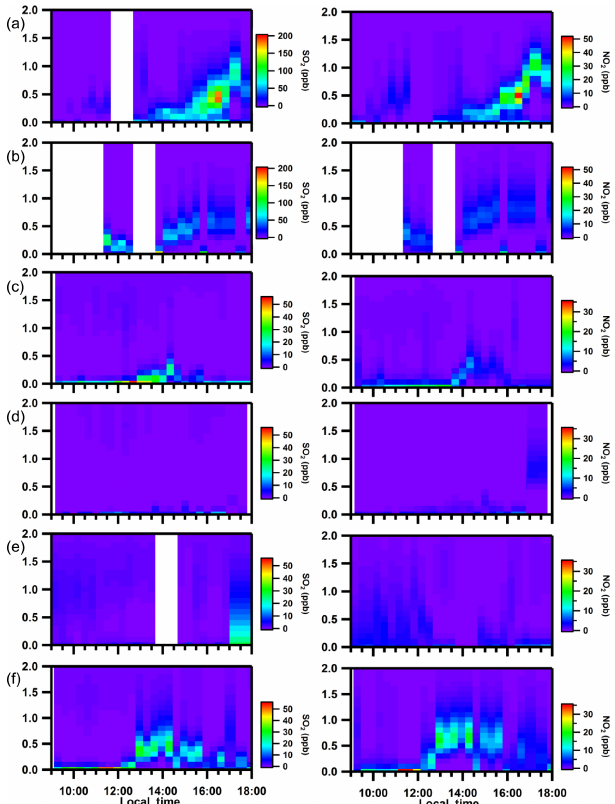
Figure 19. MAX-DOAS vertical profiles of SO 2 (left column) and NO 2 (right column): 23 August (a) , 3 September (b) , 4 Septem- ber (c) , 5 September (d) , 6 September (e) , and 7 September (f) . Note the different colour scale maximum for 23 August and 3 September.